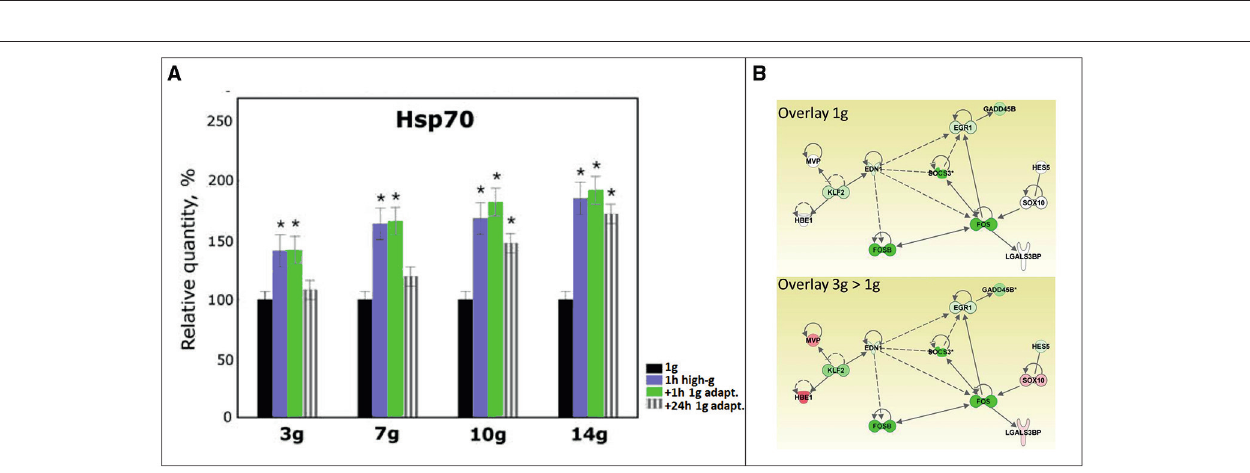
FIGURE 2 | Examples of reaching steady states. (A) Mice exposed to 2g for 4 or 24 h. Stable levels of COX-1, COX-2, and VEGF in heart tissue seems to be reached at 24 h (from Oshima et al., 2007, with permission). (B) Rats exposed for either 24h or 7 months to 2.5g (van Loon et al., 2005). In both figures data are means ± S.D., * and o identifies significance of < 0.05 with respect to 1g controls.